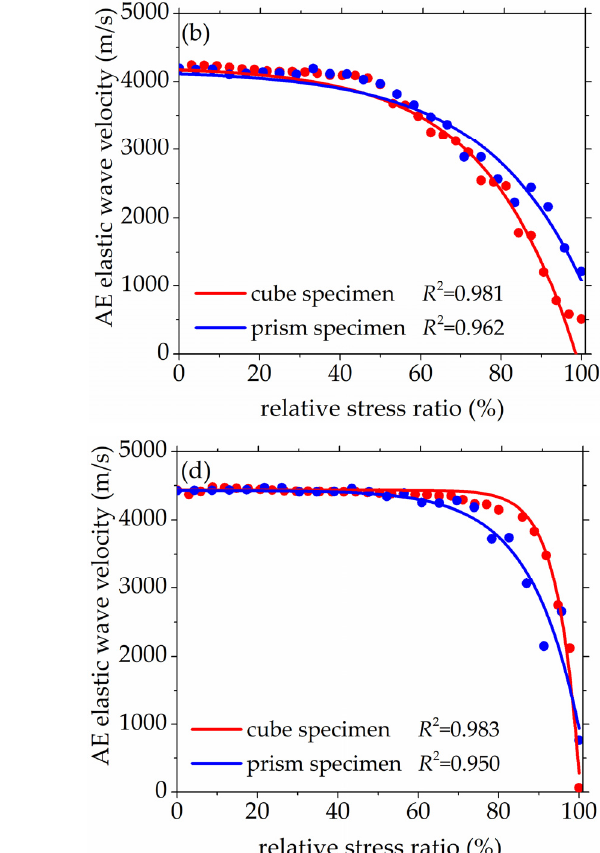
Figure 7. The relationship between AE elastic wave velocity and relative stress ratio with different maximum sizes of coarse aggregate, ( a ) 9.5 mm, ( b ) 19 mm, ( c ) 26.5 mm, ( d ) 31.5 mm. In Figures 6 and 7, the AE elastic wave velocities of concrete with different volume fractions and maximum size of coarse aggregate all decreased with the increase of relative stress ratio under axial compression stress. The AE elastic wave velocity–stress curves represent the non-linear tendency obviously, which is mainly due to the formation and development of micro-cracks having a great influence on the propagation of AE elastic waves in concrete. The value of micro-cracks’ size in relation to AE elastic waves’